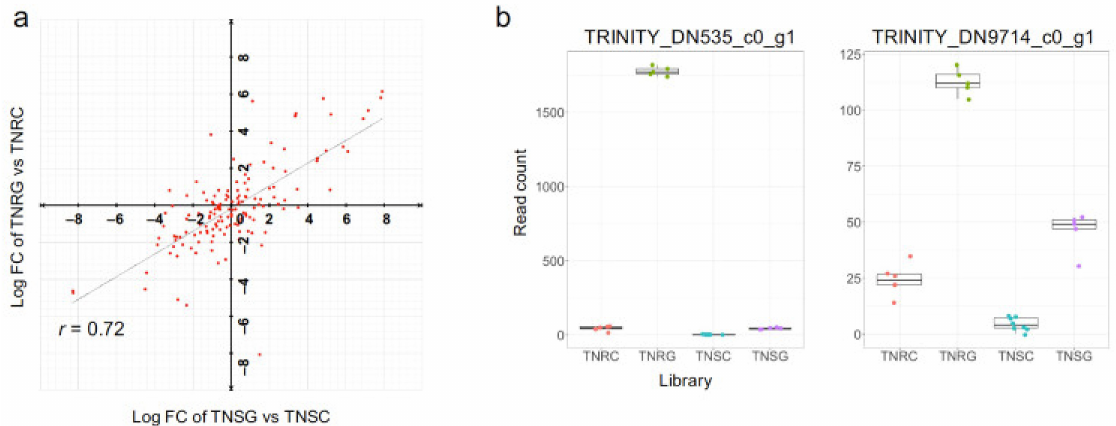
Figure 5. Glyphosate response of DEG in water-sprayed TNR (TNRC) and TNS (TNSC). ( a ) Correlation of FC (log2) in TNSG vs. TNSC, and TNRG vs. TNRC, of DEGs in TNRC vs. TNSC listed in Supplemental Tables S5 and S6. ( b ) Read count summary of two genes whose expressions were higher in TNRC than TNSC, as well as those that were boosted in TNR after glyphosate treatment. These genes were selected from the DEGs listed in Table